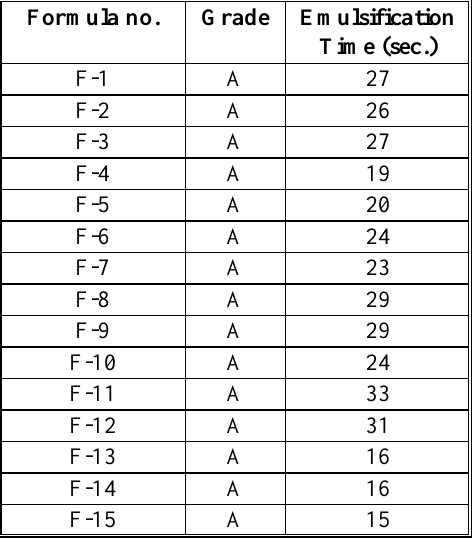
Table 5. Grade and emulsification time of SEDDS of CC.